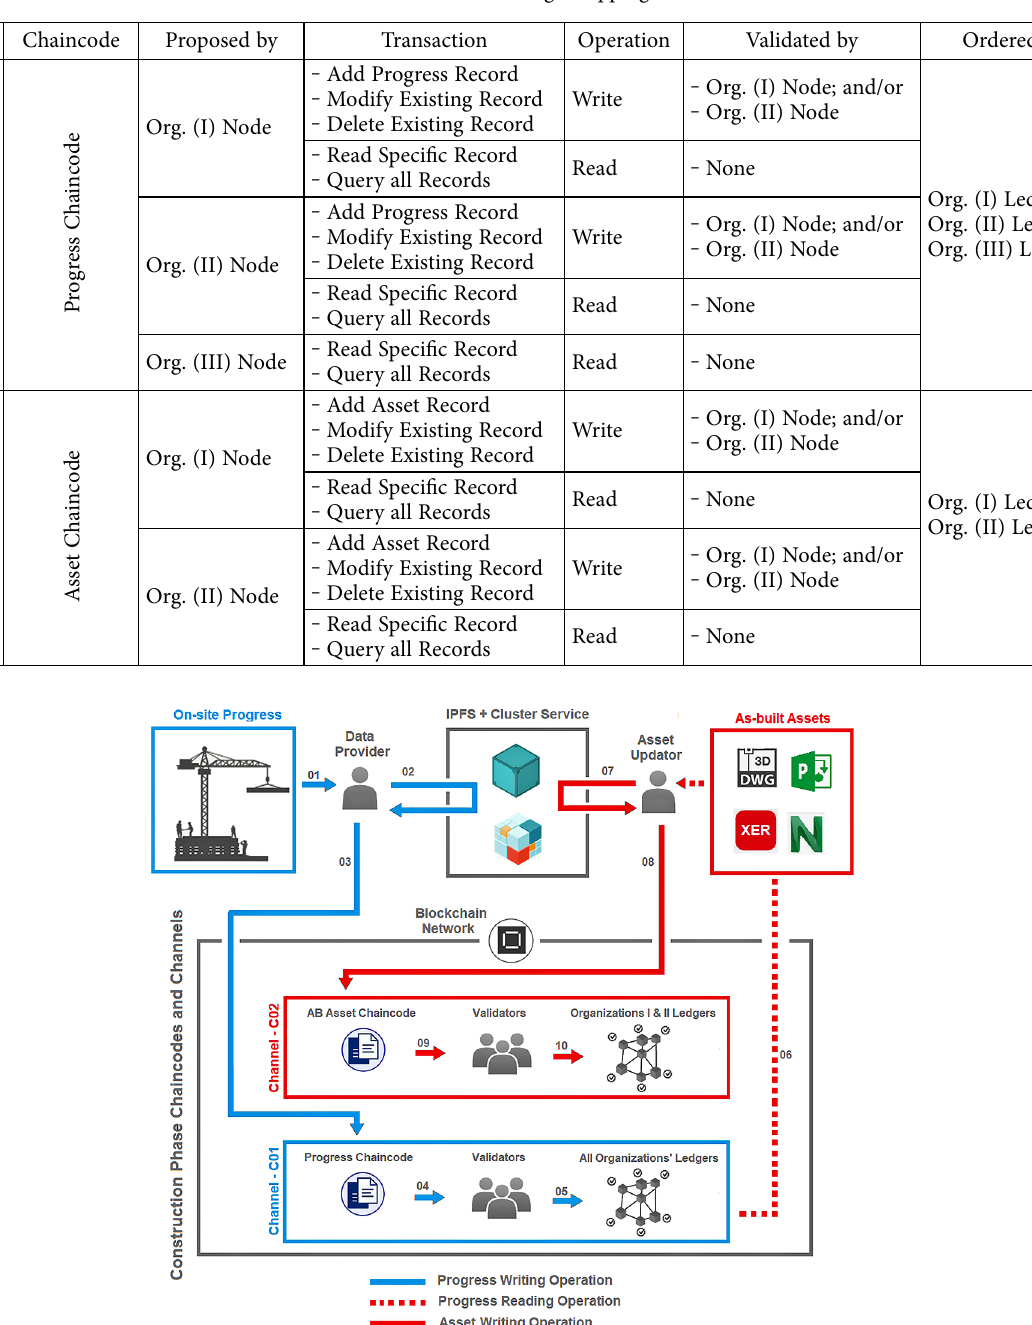
Table 2. Data exchange mapping